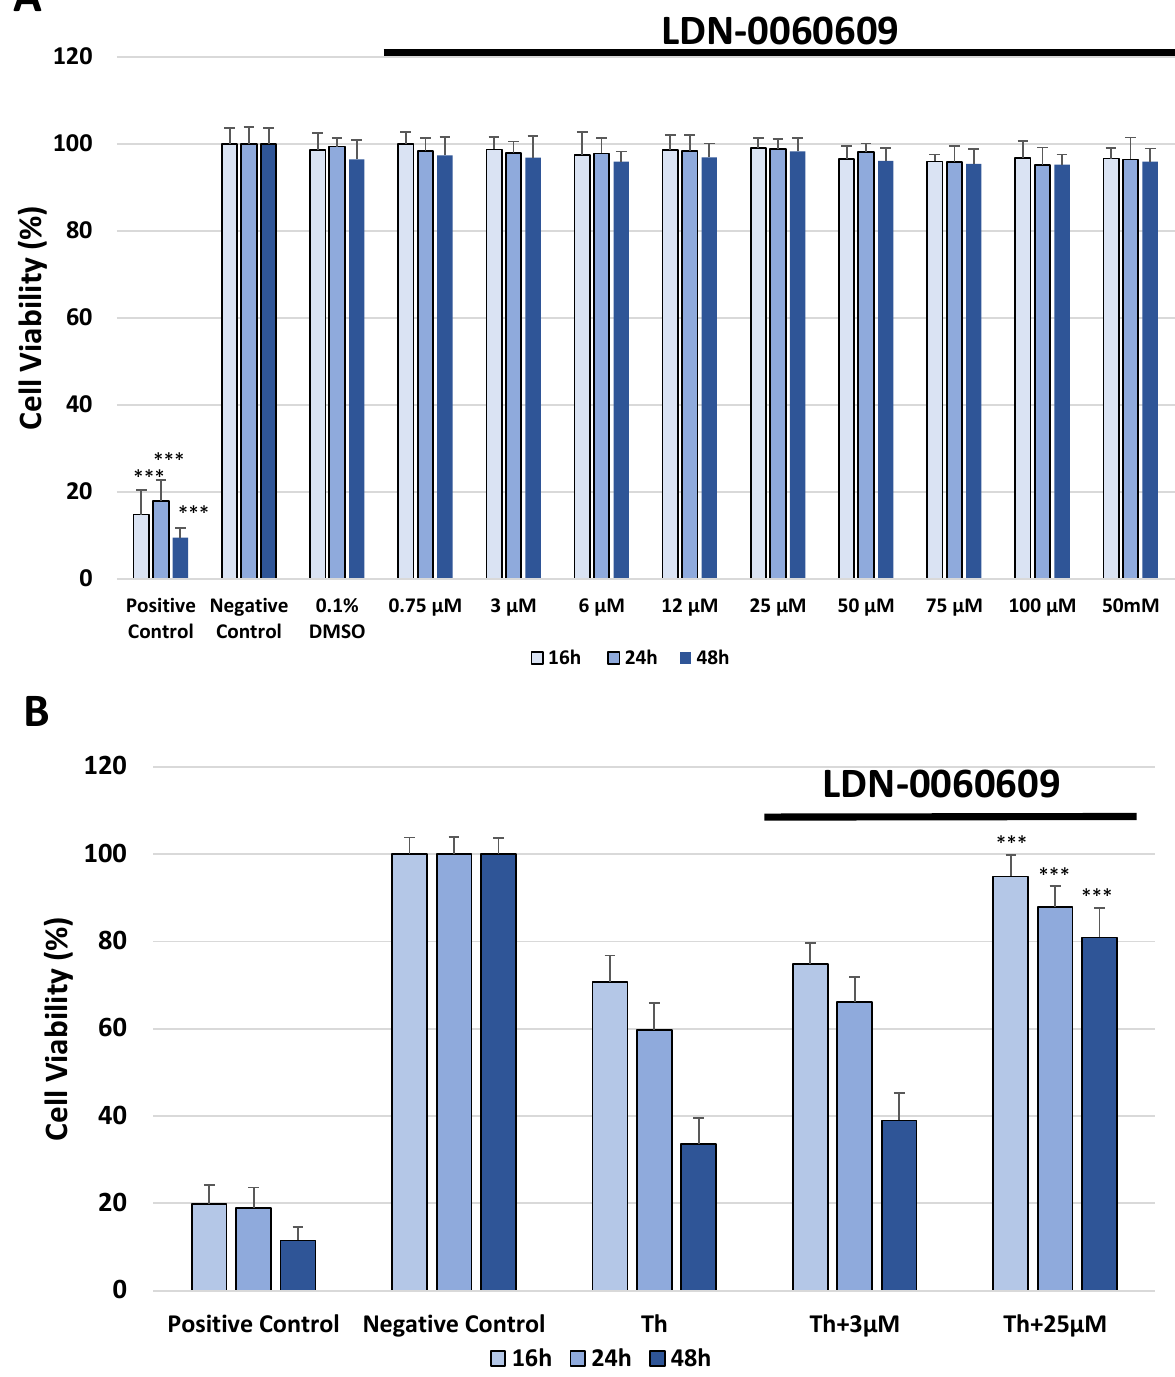
Figure 3. Analysis of cytotoxicity of the PERK inhibitor LDN-0060609 only ( A ) and after treatment of HTM cells with the Th and PERK inhibitor LDN-0060609 ( B ) by the XTT assay. Each of the statistical analysis in individual experiments was based on the results of three independent tests. Data are expressed as mean ± SE ( n = 3). On the graphs, the differences were statistically significant as follows: *** p < 0.001 versus the negative control ( A ) and versus Th ( B ). DMSO—dimethyl sulfoxide;